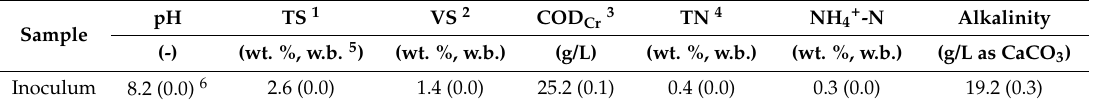
Table 1. Chemical characteristics of inoculum used in the methane potential assay of HTC-hydrolysate.